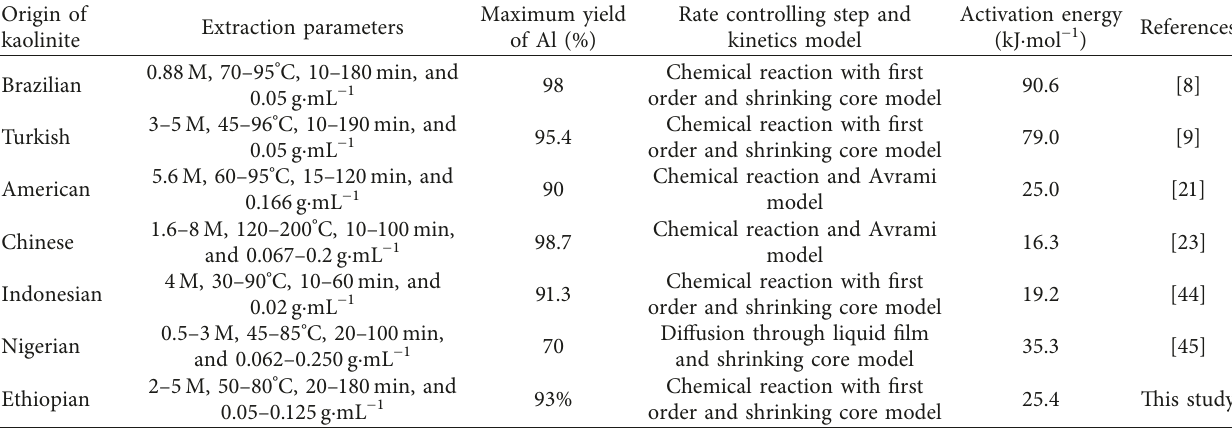
Figure 9: Extracted aluminum. (a) XRD peaks, (b) FTIR curve, and (c) SEM image of extracted aluminum chloride hexahydrate crystals extracted at 0.10g · mL − 1 , 5M, 80 ° C, and 180min. Table 7: Comparison of this study with the literature kinetics and activation energy of aluminum extraction from kaolinite using acid